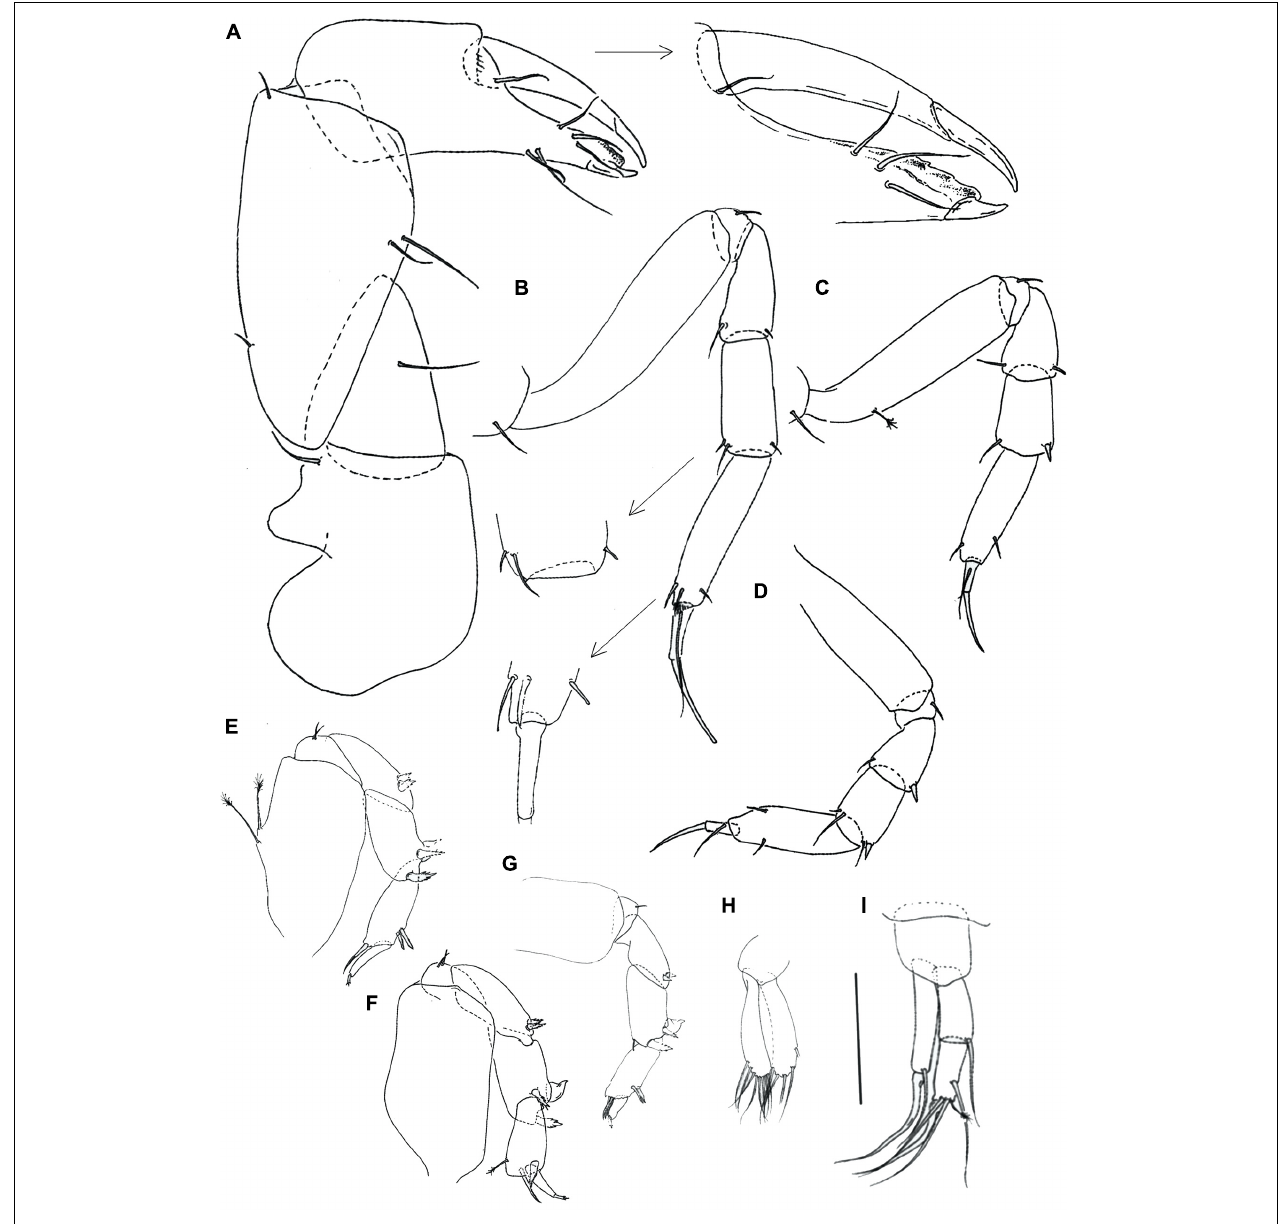
FIGURE 7 | Hamatipeda mojito n. sp. (MCZ 49272) (A) cheliped; (B) pereopod-1; (C) pereopod-2; (D) pereopod-3; (E) pereopod-4; (F) pereopod-5; (G) pereopod-6; (H) pleopod; (I) uropod. Scale: panels (A–I) = 0.1 mm.